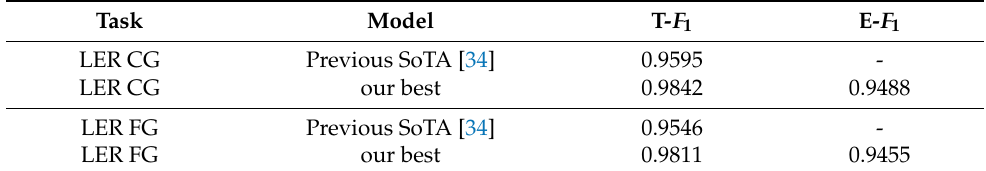
Table 10. Comparison of our best results on the two LER-tasks with the previous state of the art models of [34], where T- F 1 and E- F 1 are the token- and entity-wise F 1 scores, respectively. Task